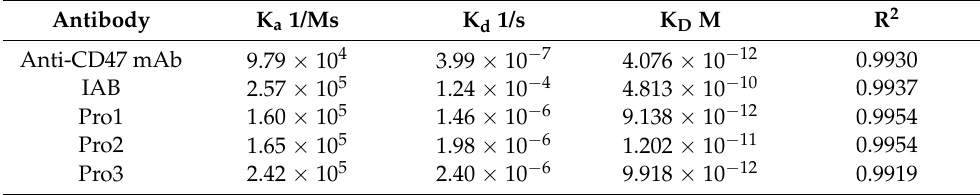
Figure 5. Affinity analysis of proteins to antigen CD47 through a BLI assay. ( A ) The positive control antibody; ( B ) prototype IAB; ( C ) Pro1; ( D ) Pro2; ( E ) Pro3. (Response units vs. time).